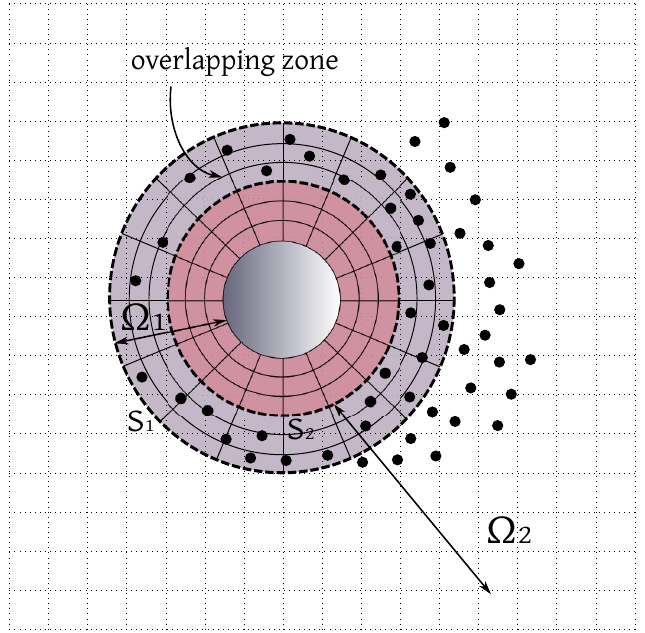
Figure 5. Domain decomposition for flow past a circular obstacle with overlapping Eulerian Ω 1 and Lagrangian Ω 2 domains. In this case, inspired from Cottet et al. [90], Ω 1 is defined by a polar mesh and a uniform Cartesian grid lies in Ω 2 for particle